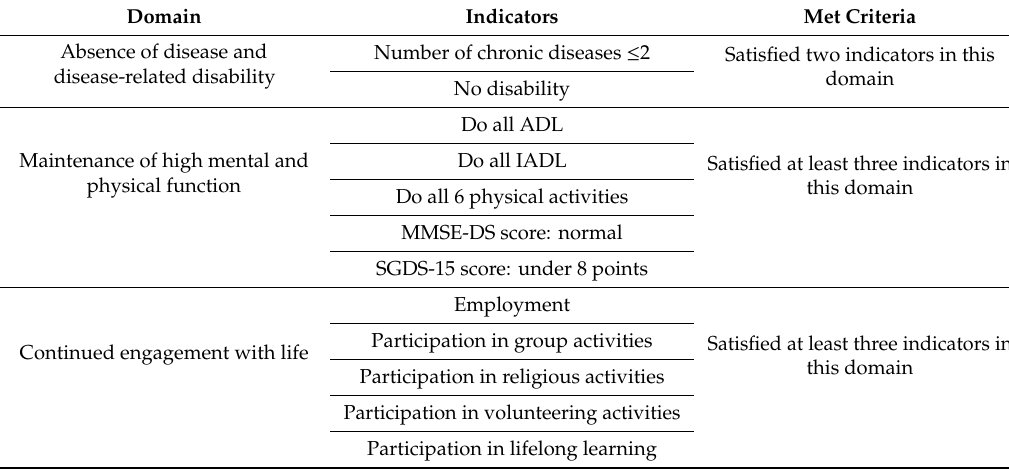
Table 1. Operational Definition of Successful Aging based on Rowe and Kahn’s